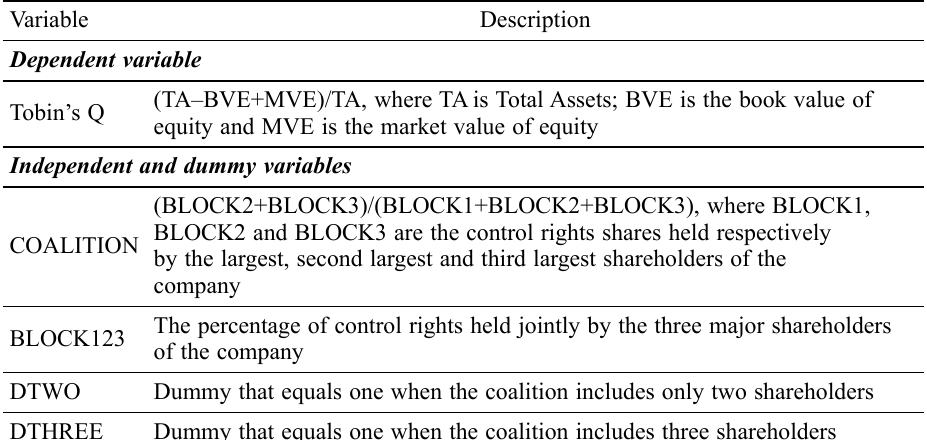
Table 1. Detailed definitions of the